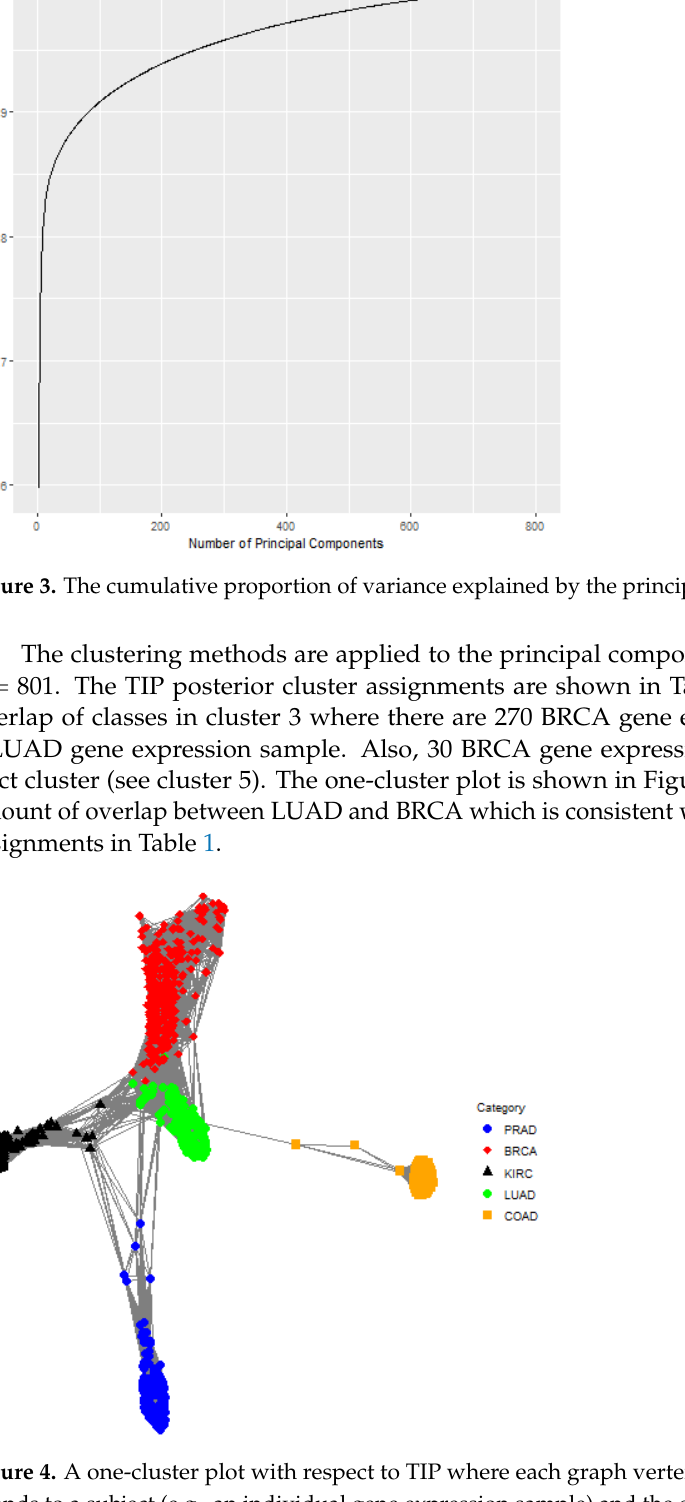
Figure 4. A one-cluster plot with respect to TIP where each graph vertex (i.e., a colored dot) corre- sponds to a subject (e.g., an individual gene expression sample) and the edge weights (i.e., the lines) correspond to the elements in the matrix ¯ B 1 . Specifically, the edge between subject i and subject j is the posterior probability that subject i and subject j are in the same cluster. Shorter lines correspond to larger posterior probabilities, so pairs of graph vertices that are closer to each other in the plot are more likely to be assigned to the same cluster. The plot shows a minor overlap between BRCA (red diamond) and LUAD (green